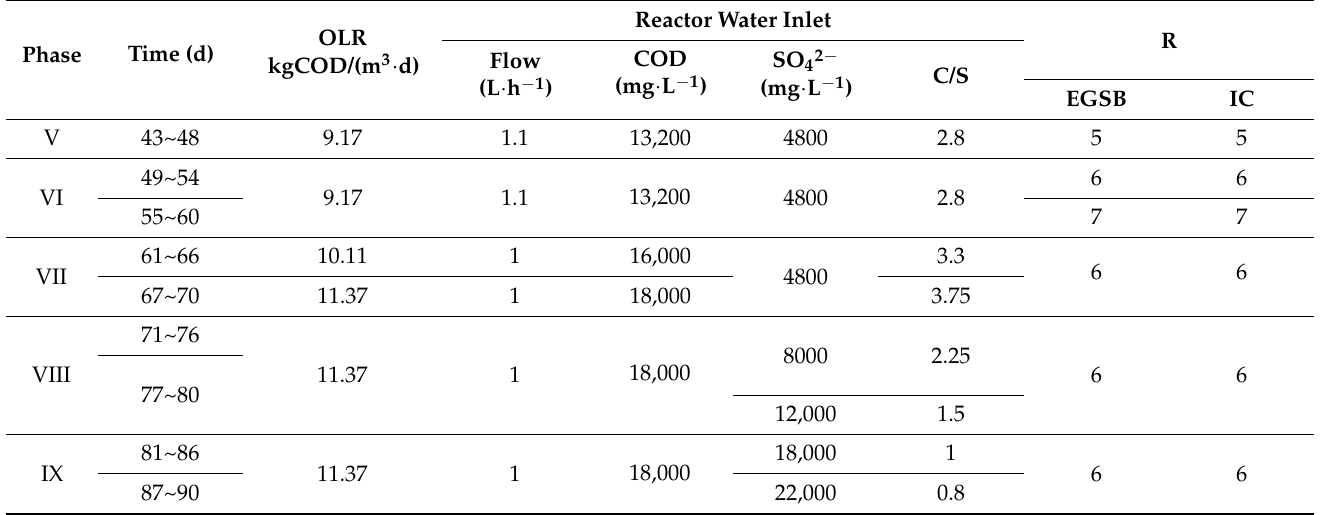
Table 4. Scheme of reactors under stable-load and high-load operating